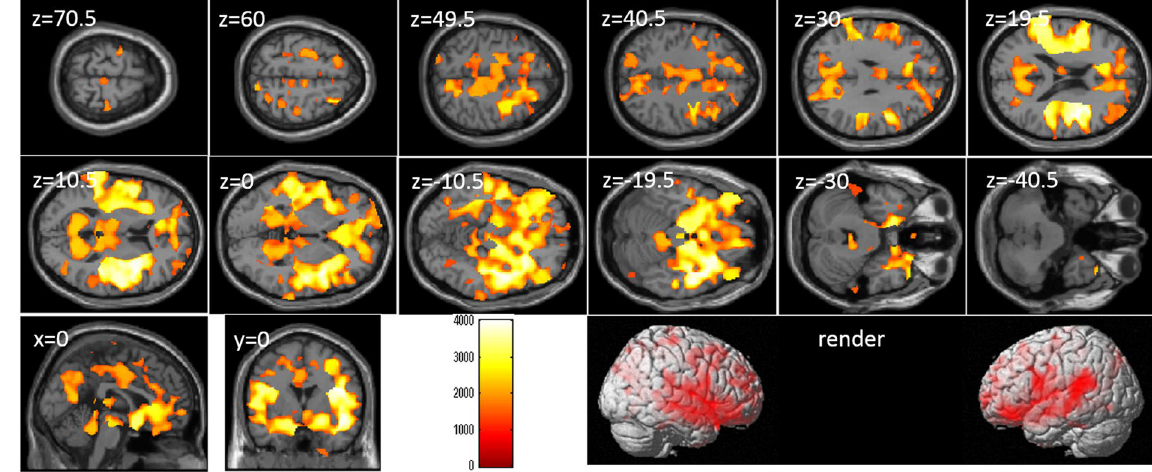
Figure 4. Relationships between complex processing speed involving spatial cognition and rGMV. Figures represent areas of significant positive correlation between Tanaka B-type intelligence test (TBIT) spatial factor scores and rGMV by multiple regression analysis corrected for effects of age and sex. The results shown were obtained using a threshold of TFCE, P < 0.05 corrected (FWE) based on 5000 permutations. In section images, the color bar represents TFCE values. Significant positive correlations were found across the whole brain.